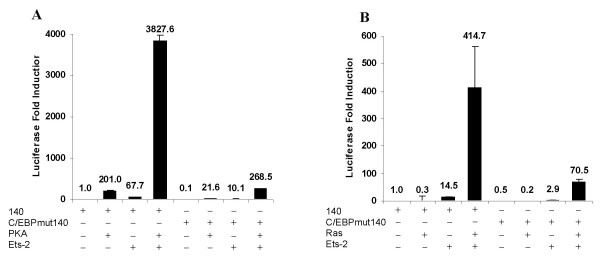
Effects of the CCAAT/enhancer element (-117 to -109) mutation on the Tkdp-1 140 bp promoter activity in A) JEG-3 and B) NIH3T3 cells. A) Basal, activated PKA, Ets-2, Ets-2+activated PKA-dependent activation of the wild type and C/EBP-mutated minimal promoter in JEG-3 cells. B) Basal, activated Ras, Ets-2, Ets-2+activated Ras-dependent activation of the wild type and C/EBP-mutated promoter in NIH3T3 cells. Luc activities are expressed relative to that of the basal activity of the 140 bp promoter and data are shown as mean ± SEM (n = 3). Following values are significantly different at P < 0.05: A) 140+PKA vs. C/EBPmut140+PKA; 140+Ets-2 vs. C/EBPmut140+Ets-2; 140+Ets-2+PKA vs. C/EBPmut140+Ets-2+PKA and B) 140+Ets-2 vs. C/EBPmut140+Ets-2 and 140+Ets-2+Ras vs. C/EBPmut140+Ets-2+Ras.